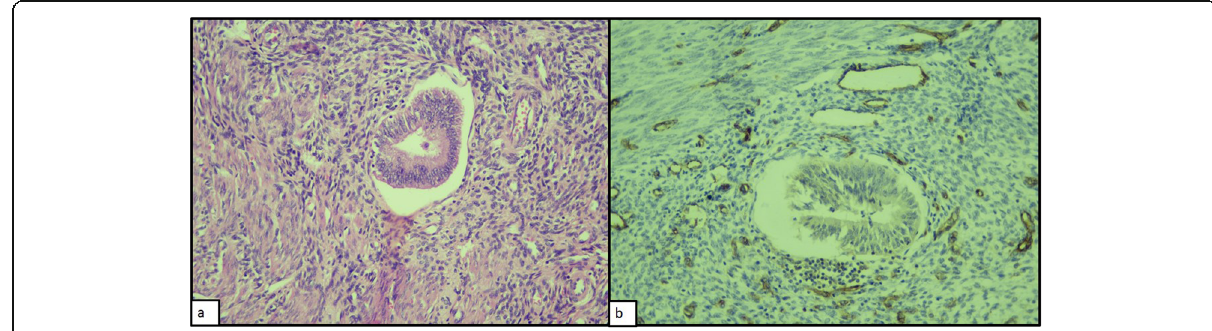
Fig. 3 Potential mimic of LVI: a retraction cleft with no endothelial lining (H & E X 20 M). b Confirmed by immunohistochemical stain CD31